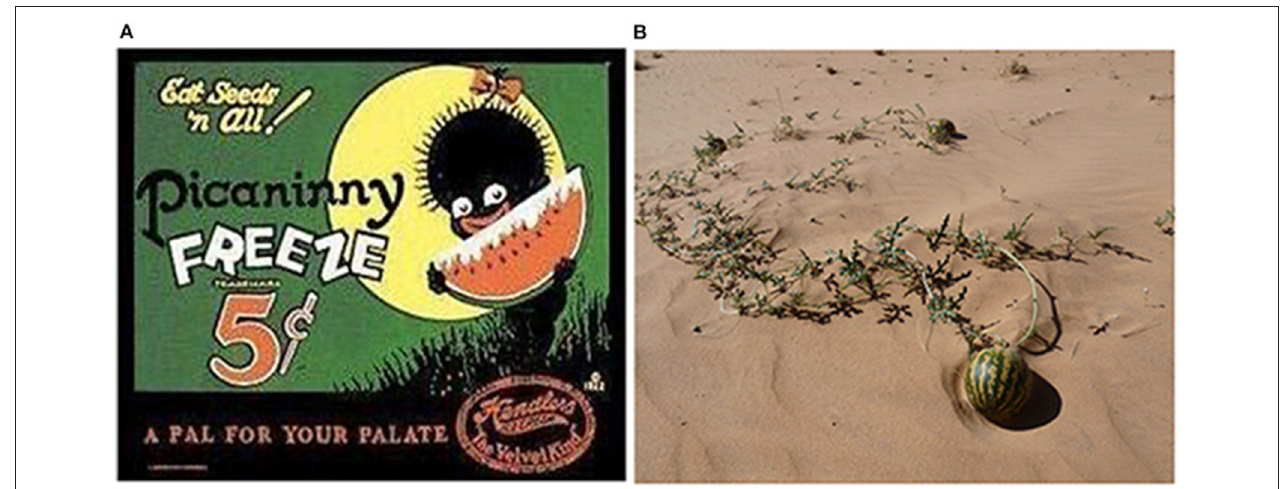
FIGURE 2 | Watermelon (Citrullus sp.). (A) A racist caricature from 1922 depicting the African-American watermelon stereotype. Source: United States Public Domain. (B) Colocynths growing in the Adrar Desert, Mauritania. Source: Ji-Elle. CC BY-SA